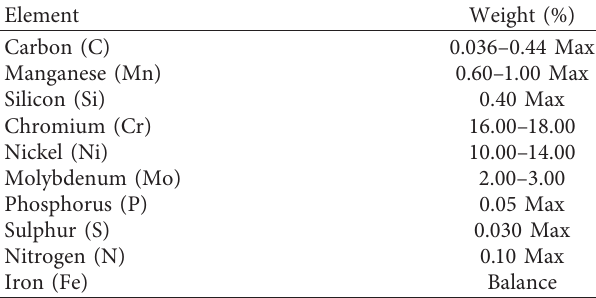
Table 1: Chemical composition of SS630